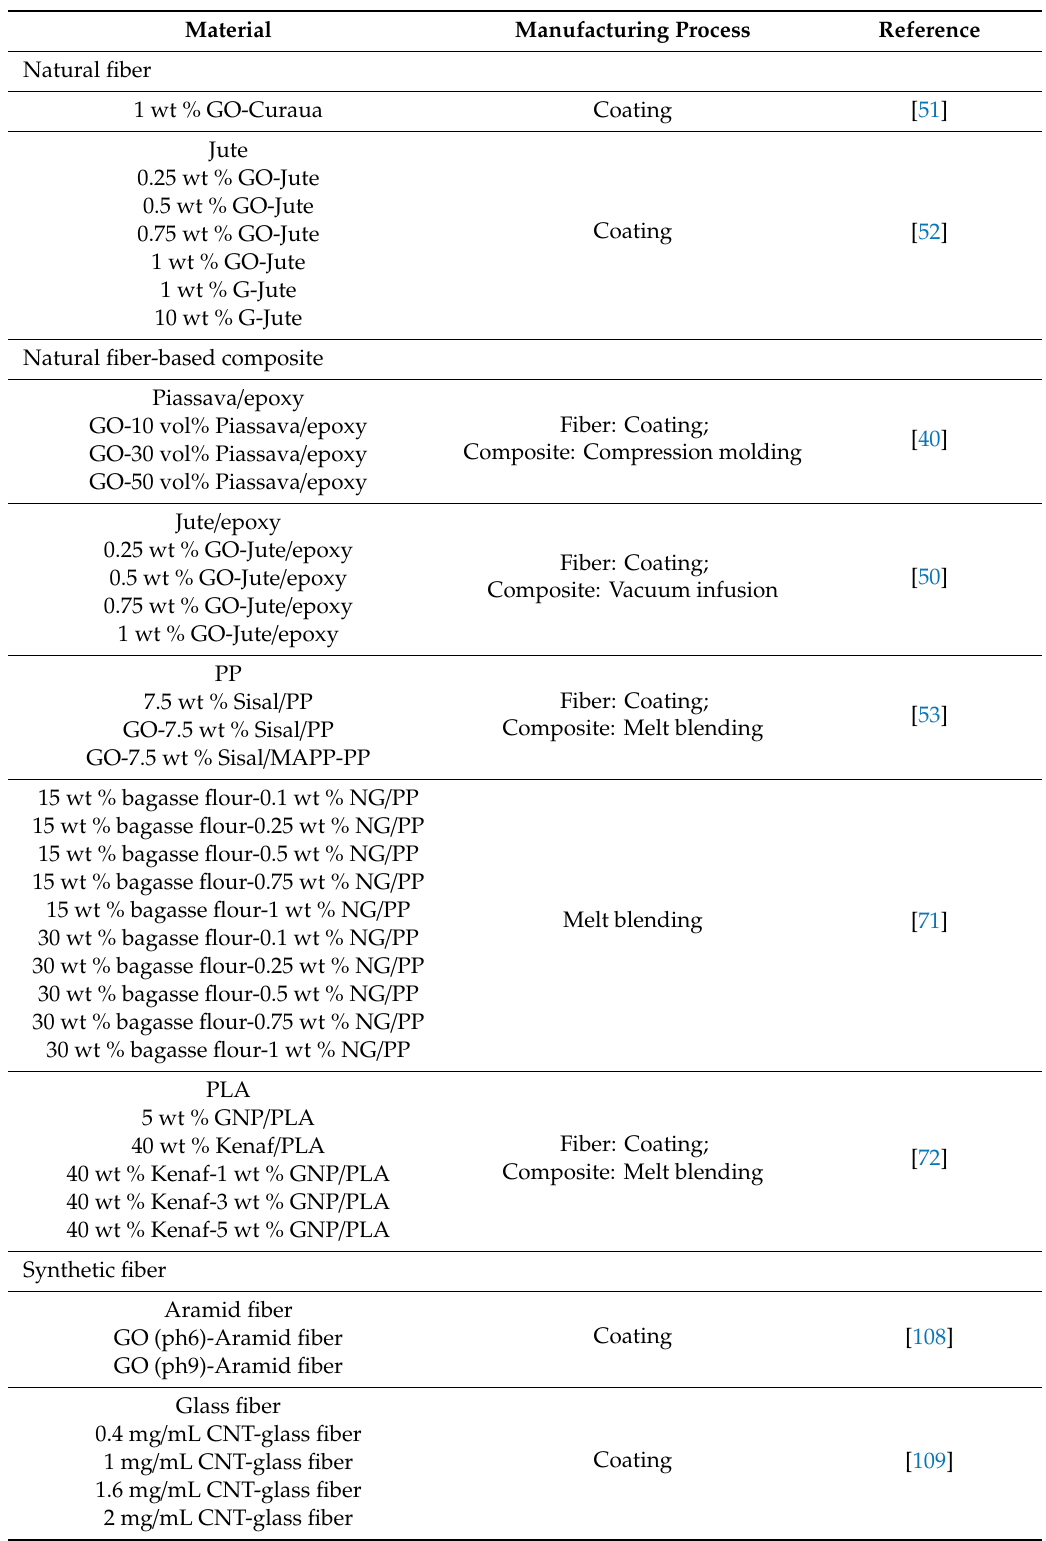
Table 1. Manufacturing processes of natural and synthetic fibers with graphene-based material, and their